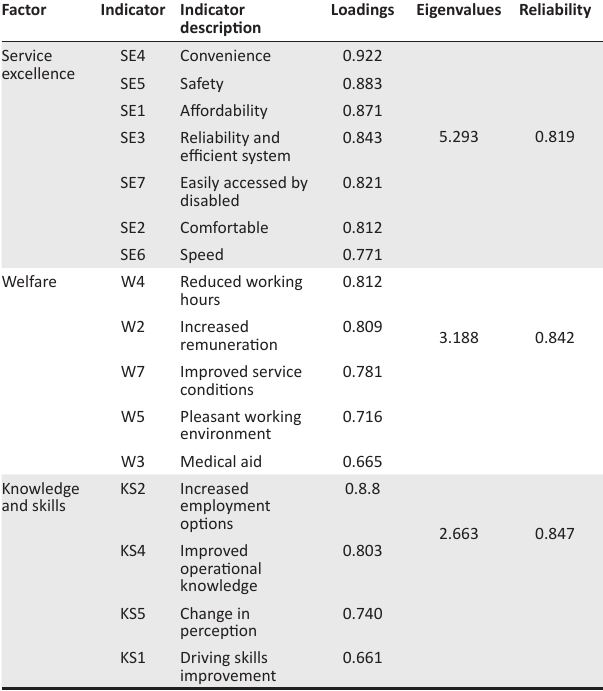
TABLE 3: Results of factor analysis for